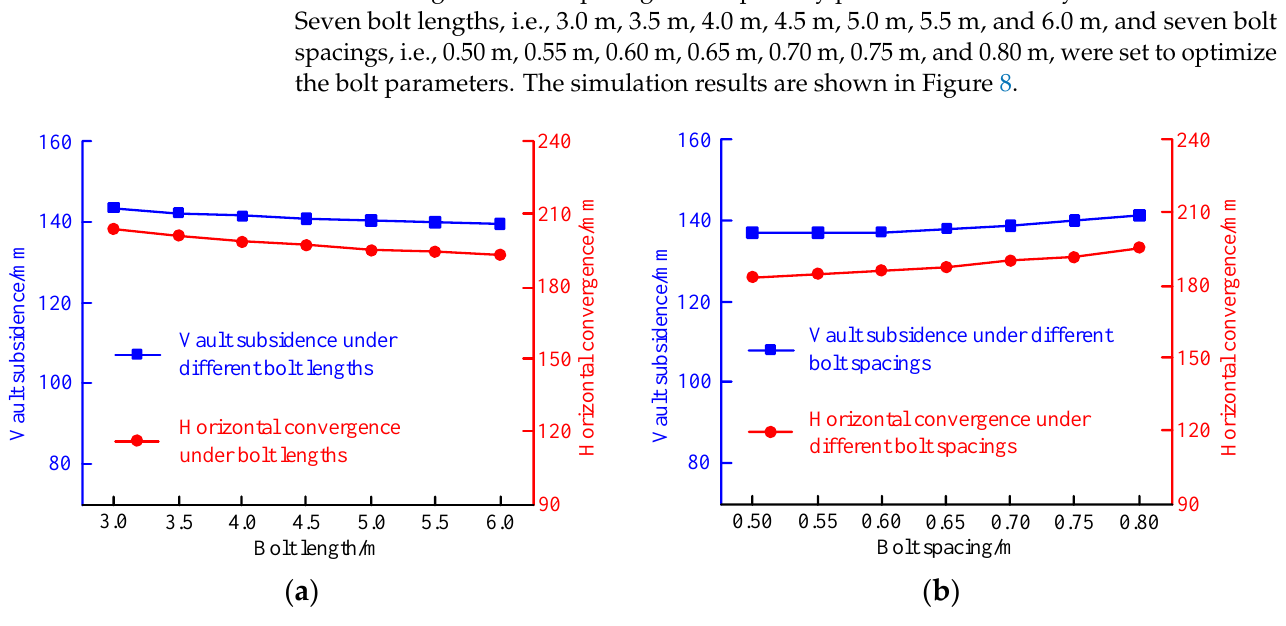
( b ) Figure 7. ( a ) Tunnel deformation curves under different steel arch specifications and ( b ) tunnel deformation curves under different steel arch spacings. Tunnel deformation curves under different steel arch frame parameters. According to Figure 7, for I20b, the tunnel vault subsidence is 152.1 m and the maximum horizontal displacement is 211.7 m. For I22b, the above two values are 139.6 m and 178.5 m, respectively. For I28a, they decline to 122.5 m and 163.1 m, respectively.